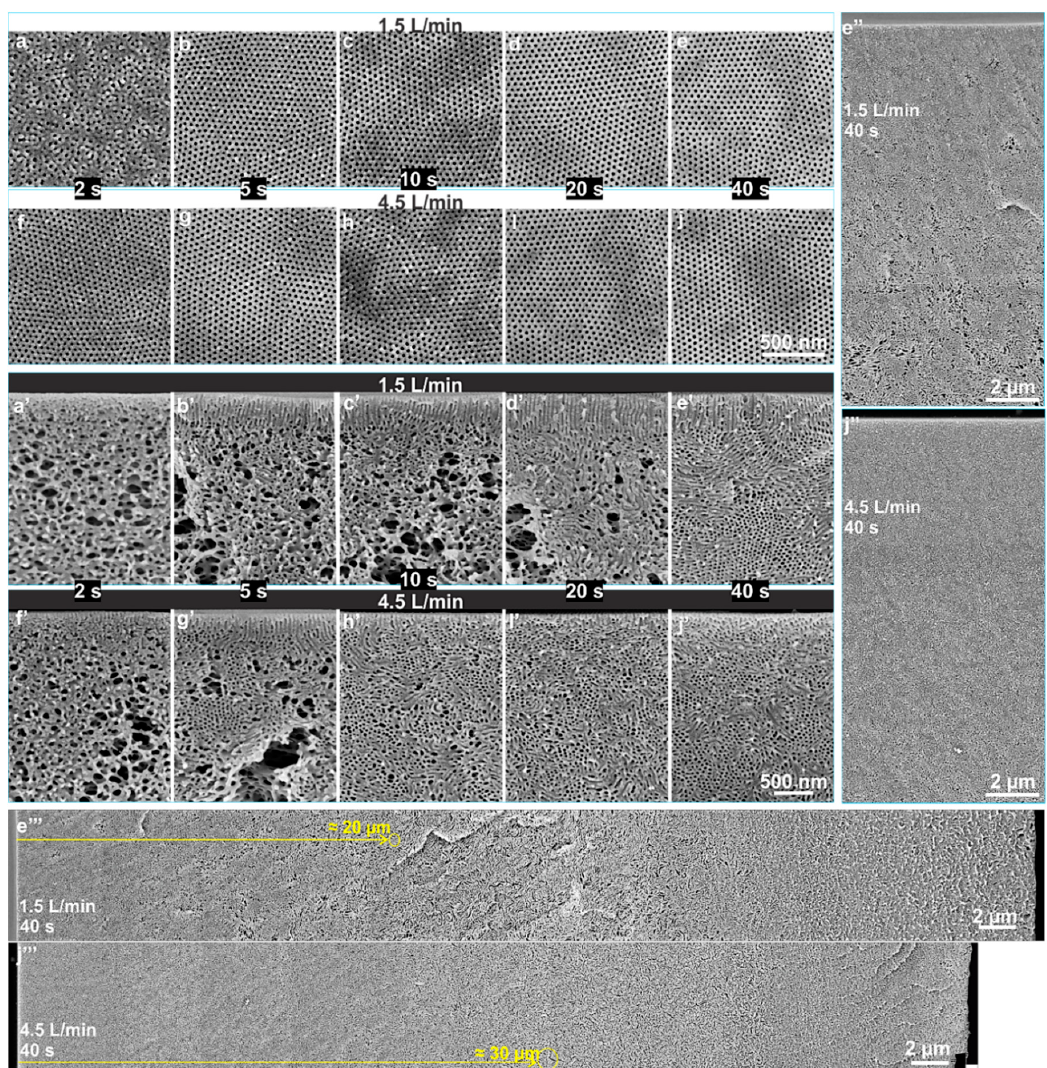
Figure 4. SEM micrographs of the top surfaces ( a – j ) and the cross-sections ( a’ – j’ ) of the flat sheets cast using block copolymer solution of 24 wt% PS- b -P4VP 18150 in DMF/THF 1/1 (wt/wt). The